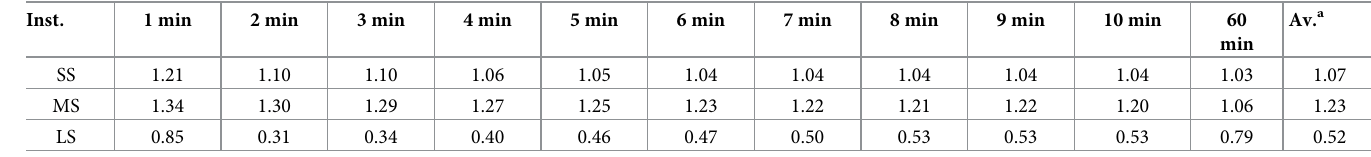
Table 2. Average (Av.) makespan of the first 10 minutes and best result within 1 hour of execution time for SS, MS, and LS instances.